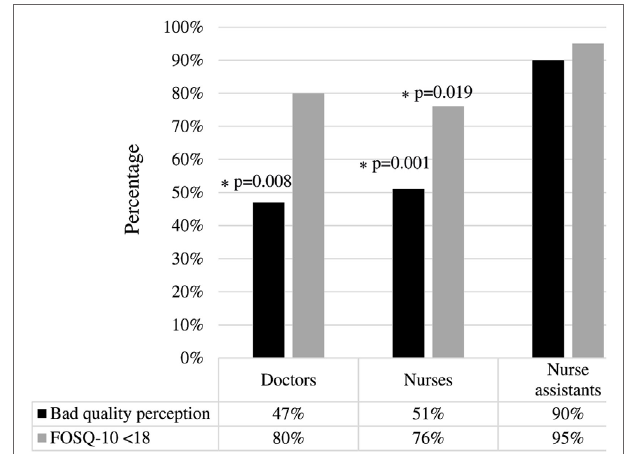
FigUre 1 | Sleep quality comparison between professional categories. Nurse assistants had worse sleep quality than the rest of workers, according to both perception and to the Functional Outcomes of Sleep Questionnaire (FOSQ)-10. *There is a significant difference between doctors and nurse assistants according to “poor-quality perception” ( p = 0.08), and also between nurses vs nurse assistants according to either “poor-quality perception” or FOSQ-10 < 18 ( p = 0.001 and p = 0.019).